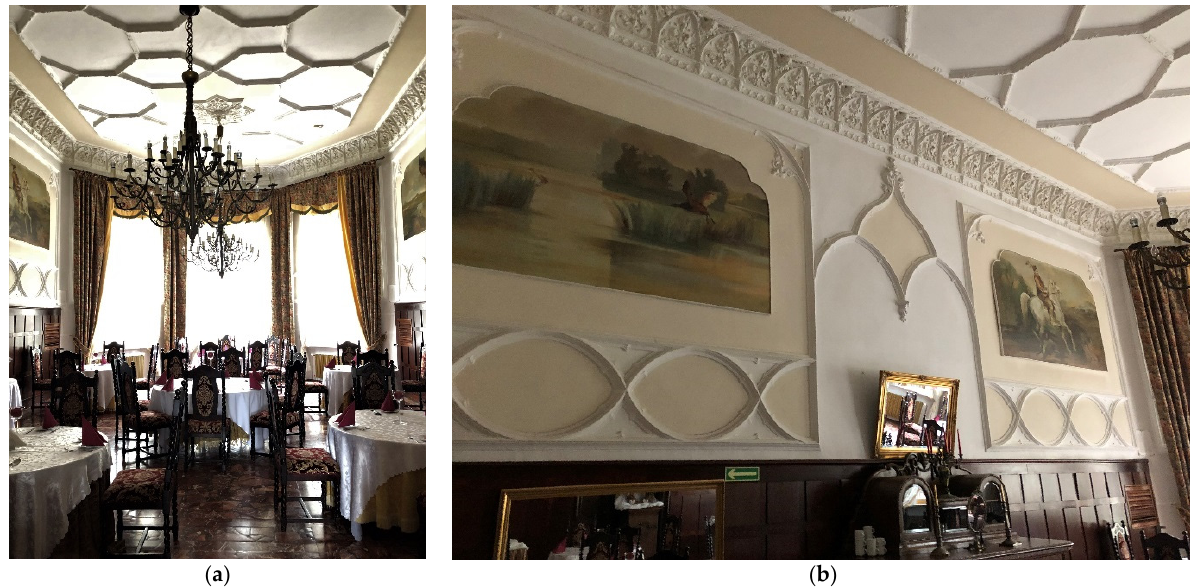
Figure 9. View of the interior of the Palace in Maciejewo before the recent adaptive re-use ( a ) the main ballroom; ( b ) the wall and ceiling decorations; photo by the author.